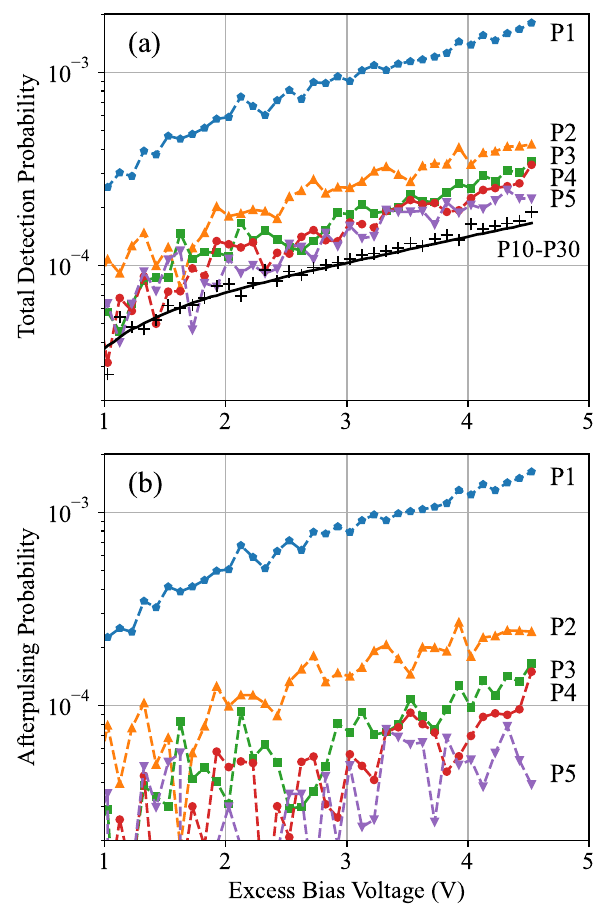
Figure 8. Total ( a ) and pure afterpulsing ( b ) detection probabilities in the first five pulse periods (P1–P5) after an avalanche detection as a function of V ex at g = 0.3. The (pure) afterpulsing probabili- ties are obtained by subtracting the estimated dark-count probabilities (shown by P10–P30) from the total (measured) detection